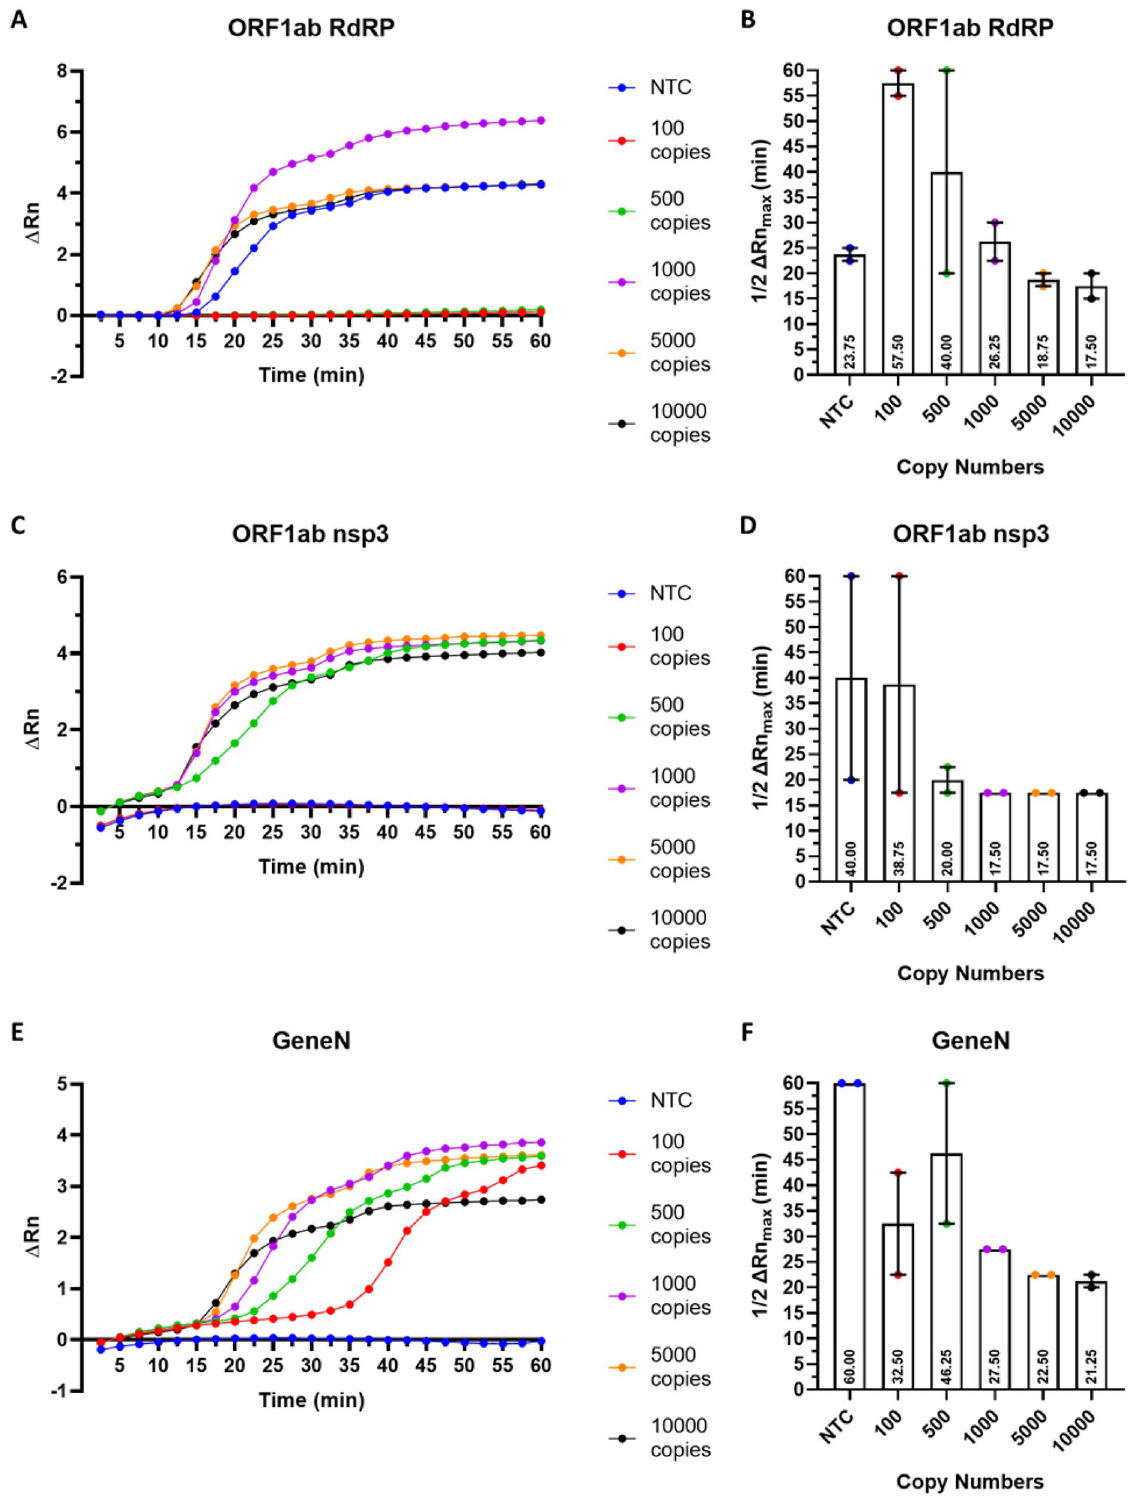
Figure 5. Fluorescent detection of SARS-CoV-2 RNA using RT-LAMP. Real-time measurement of SARS- CoV-2 RNA using RT-LAMP for ( A ) ORF1ab RdRP, ( C ) ORF1ab nsp3 and ( E ) Gene N, showing the normalised fluorescent signal (ΔRn) against the reaction time. Quantification of the time to reach half the maximum fluorescent signal (ΔRn max ) for ( B ) ORF1ab RdRP, ( D ) ORF1ab nsp3 and ( F ) Gene N. Results are displayed as the mean of 2 biological repeats, error bars represent